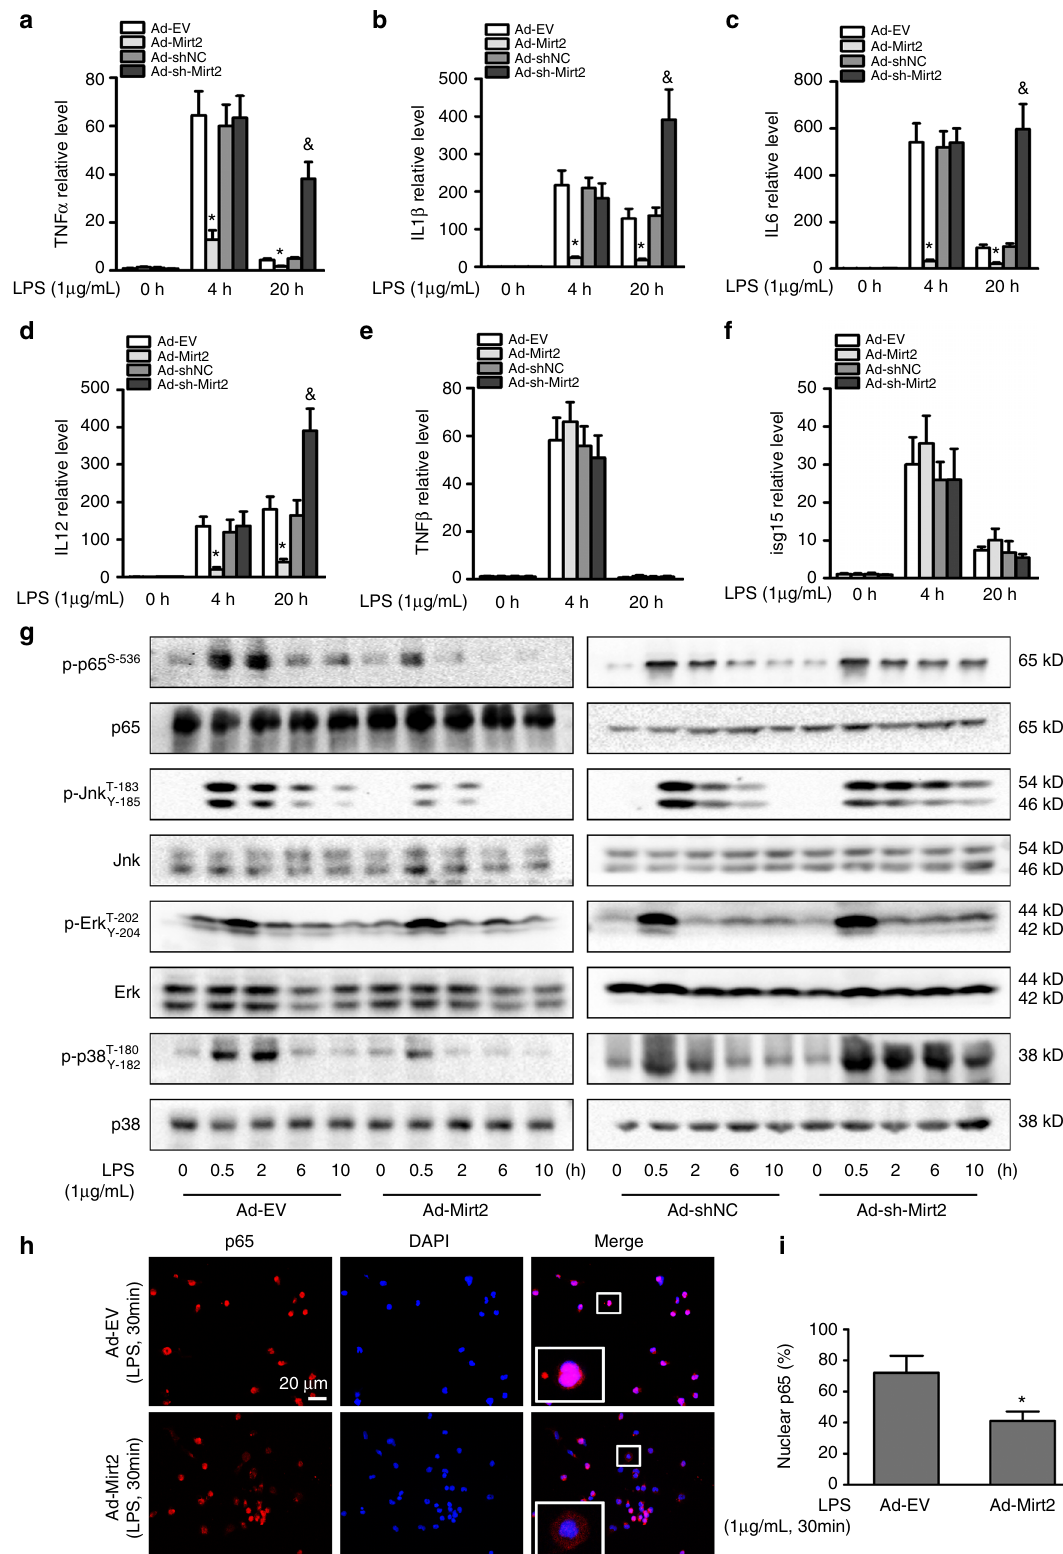
Fig. 4 Mirt2 inhibits LPS-induced in fl ammatory responses in macrophages. a – f Effects of Mirt2 overexpression or Mirt2 knockdown on the expression of in fl ammatory factors induced by LPS in cultured peritoneal macrophages, as determined by qRT – PCR. Data represent the mean ± SEM of three independent experiments. * P < 0.05 vs. Ad-EV or Ad-shNC group. g Effects of Mirt2 overexpression or Mirt2 knockdown on the activation of NF- κ B and MAPK pathways induced by LPS in cultured peritoneal macrophages, as determined by Western blot. h Effects of Mirt2 on p65 nuclear translocation in LPS-treated macrophages, assayed by immuno fl uorescent detection. i Quanti fi cation of p65 nuclear translocation in panel h . Data represent the mean ± SEM of three independent experiments. * P < 0.05 vs. Ad-EV. Two-tailed Student ’ s t-test for two groups and one-way ANOVA for multiple